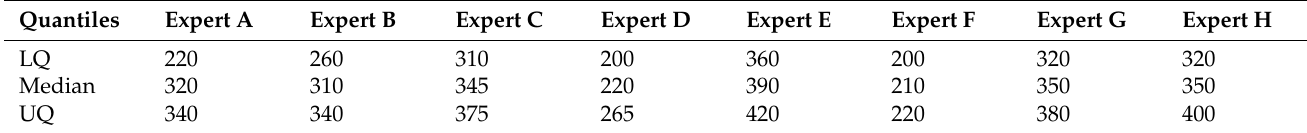
Table 4. Elicited quartiles for total GB electricity demand in 2040.